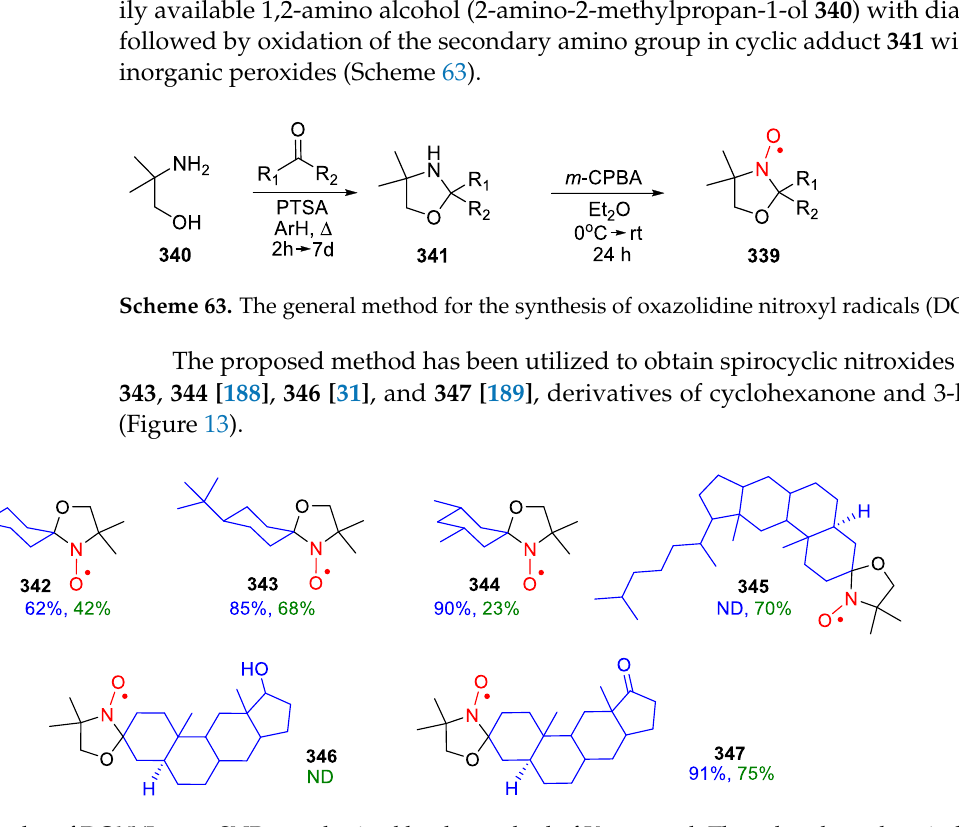
Figure 13. Examples of DOXYL-type SNRs synthesized by the method of Keana et al. The colored numbers indicate the yields—blue for the cyclic amine, and green for the radical.